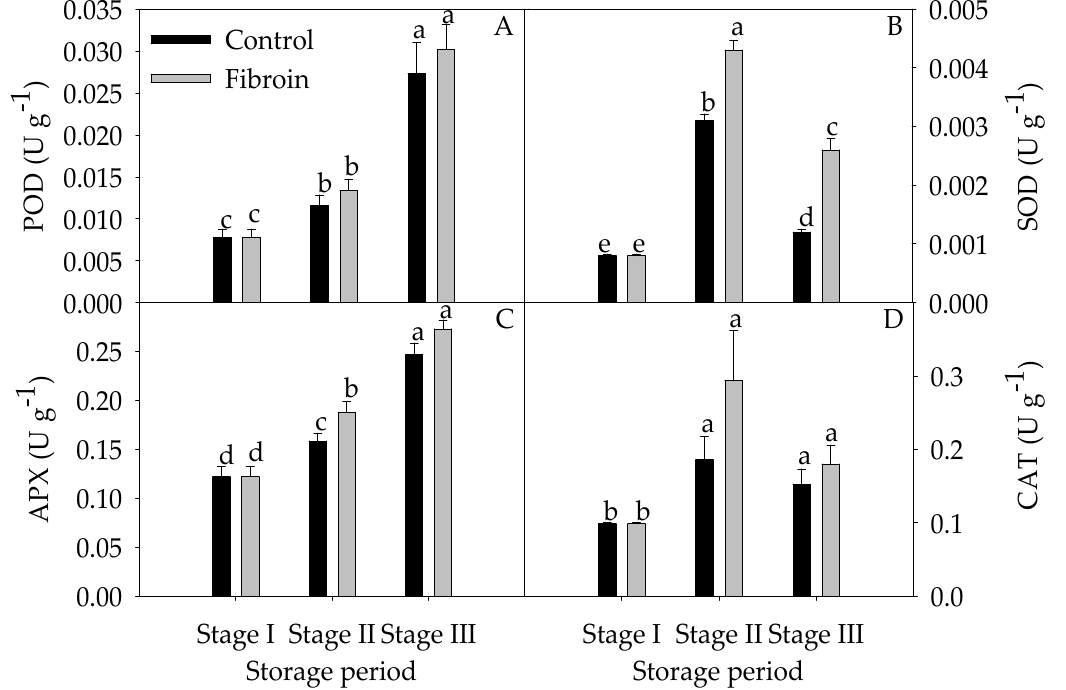
Figure 3. Effects of fibroin treatment on activities of peroxidase (POD) (A), superoxide dismutase (SOD) (B), ascorbate peroxidase (APX) (C), and catalase (CAT) (D) in peels of harvested banana fruit during cold storage. The data are presented as means ± standard errors ( n = 3). The means with different letters are significantly different ( p < 0.05).